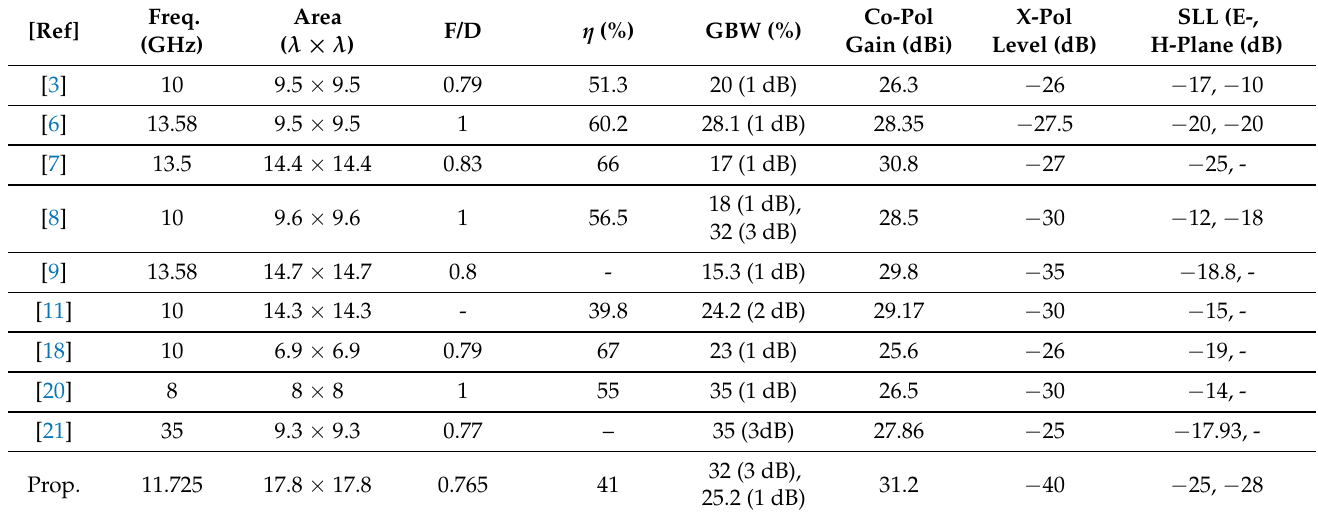
Table 1. Comparison of the RA performance with the published